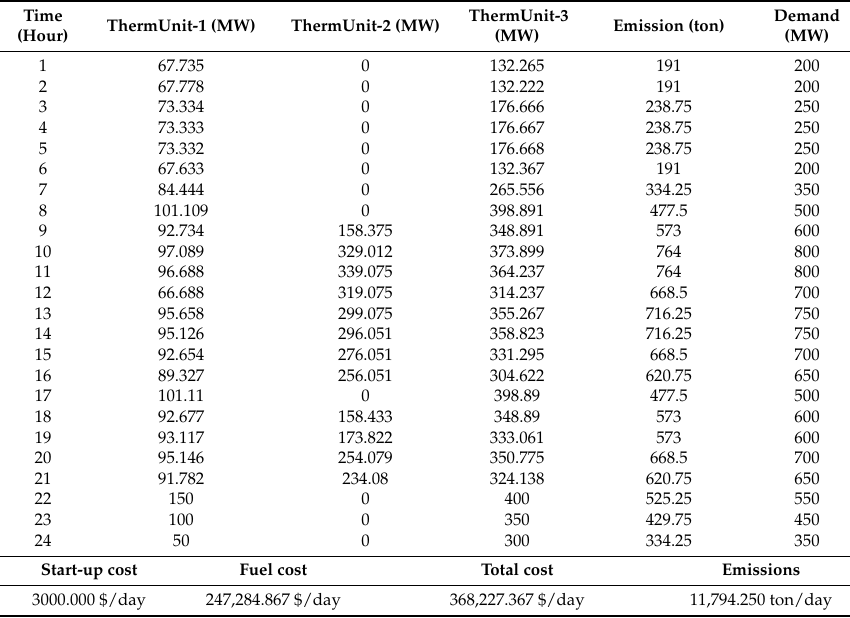
Table 5. Base case of 3 thermal Generating units’ applying the